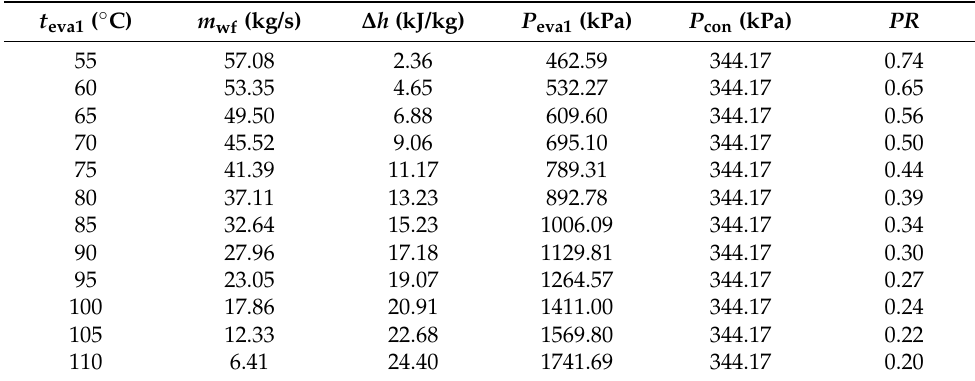
Table 3. Parameters varying with evaporation